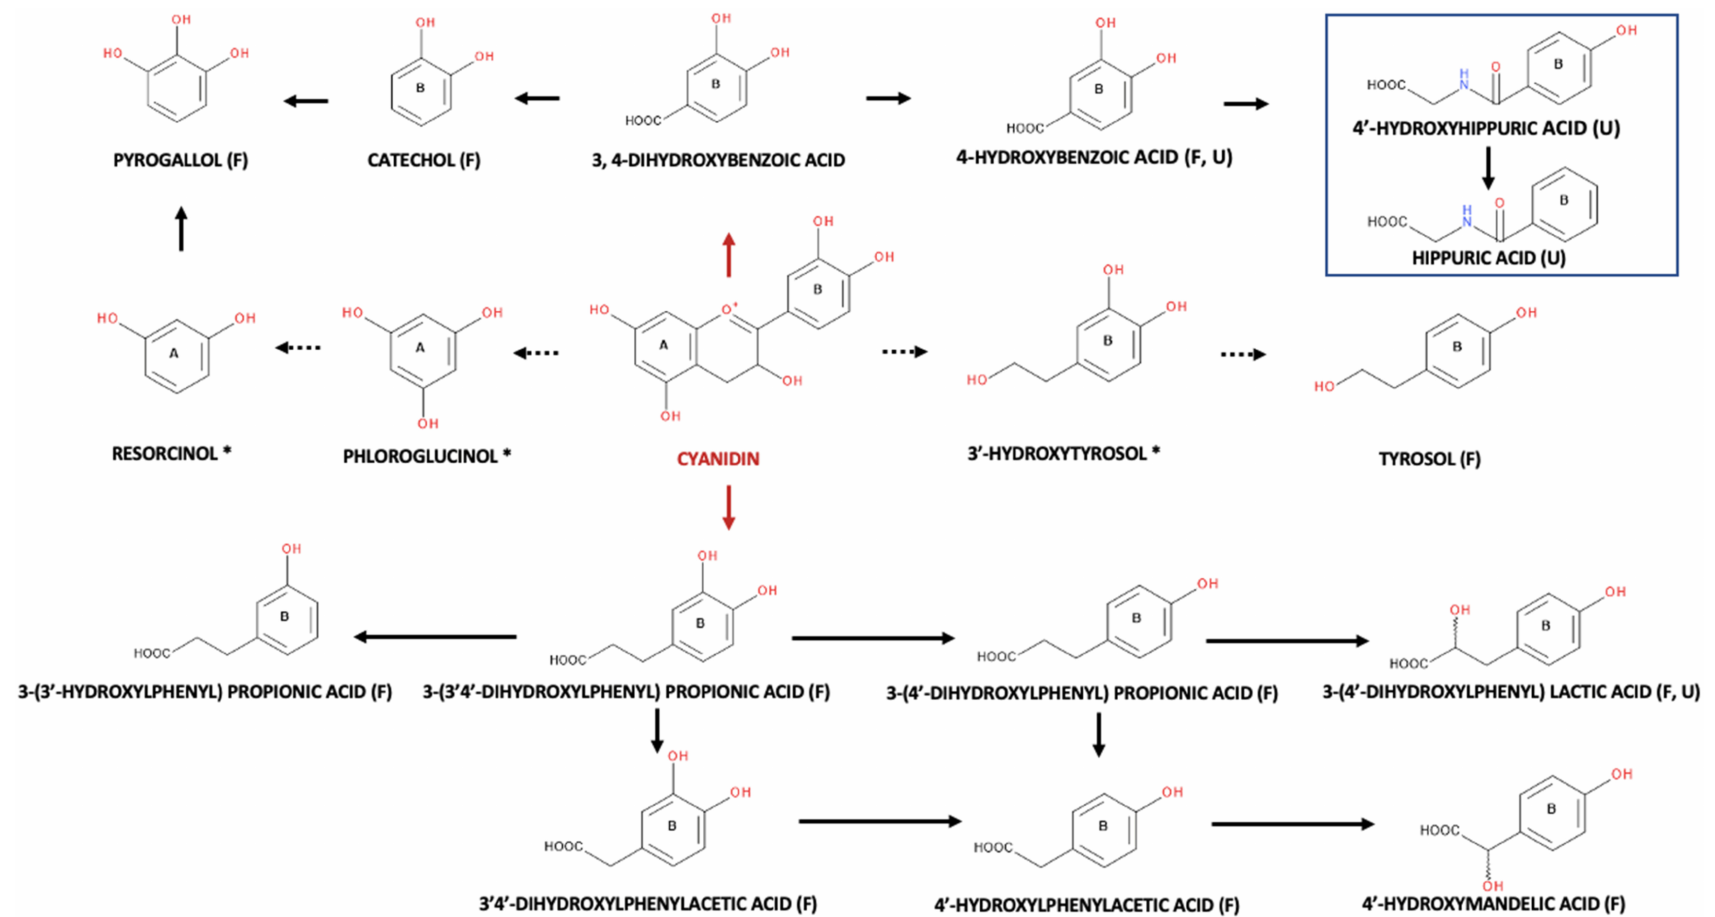
Figure 5. The proposed pathways for the conversion of cyanidin-related anthocyanins from red raspberry to phenolic acids from the illustration in the work of Gonz á lez-Barrio et al. Reprinted from ref. [40]. According to the authors, the letter F indicates the identified metabolites in faecal suspensions, U shows the catabolites present in urine, and * indicates potential intermediate products but not in detectable